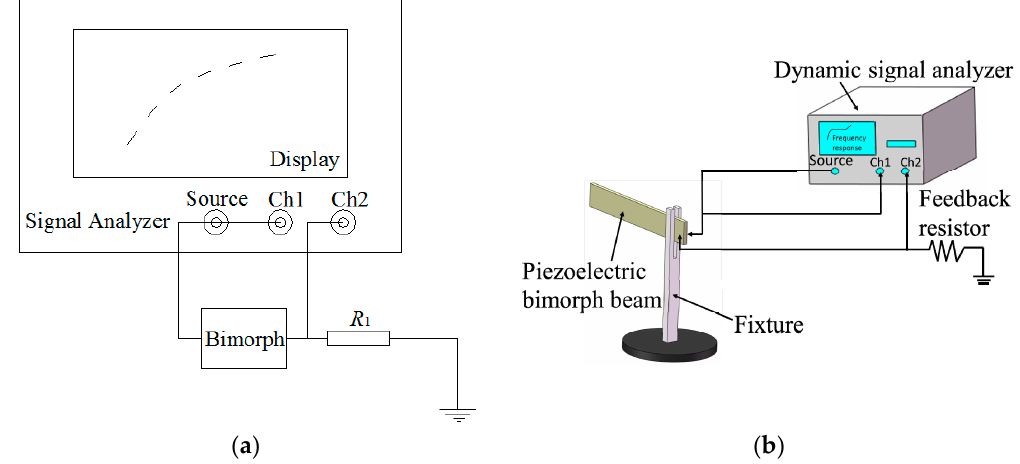
Figure 3. The admittance test of a piezoelectric bimorph beam. ( a ) The detection principle; ( b ) Schematic diagram of the admittance test system.